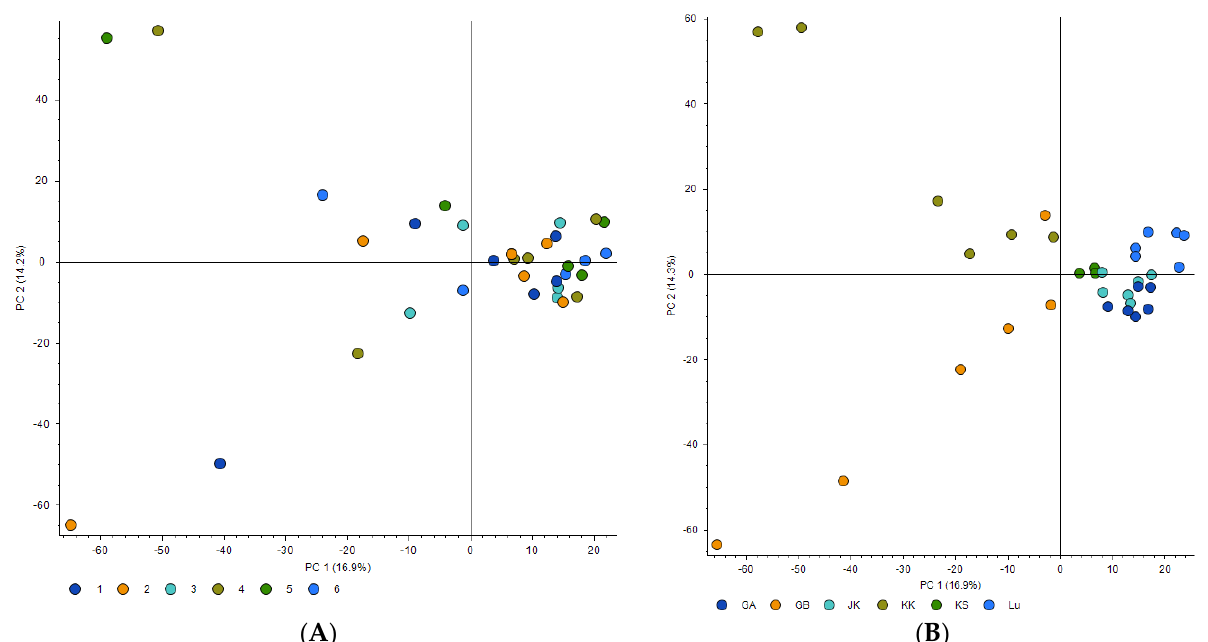
Figure 1. PCA score plots of HRMS-data of RW sampled from six DWTPs: ( A ) (Left) Samples are labeled according to occasion of sampling. 1: May 2017, 2: July 2017, 3: September 2017, 4: November 2017, 5: January 2018, 6: March 2018. ( B ) (Right) Same score plot as in figure A but samples are now labeled according to the city of the DWTP. GA: Gävle, GB: Gothenburg, JK: Jönköping, KK: Karlskrona, KS: Karlstad, Lu: Luleå. Percentages bracketed in axis legends are contribution ratios.